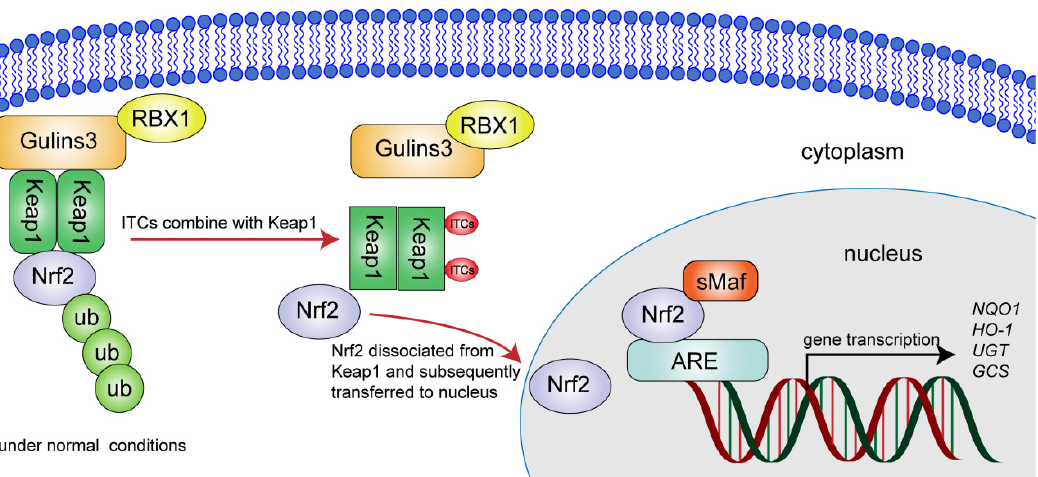
Figure 2. The regulatory effect of isothiocyanates on Keap1-Nrf2-ARE signaling pathway. Under normal conditions, Nrf2 is anchored into the cytoplasm by binding to Keap1, which facilitates the proteasomal degradation by ubiquitination. Under the action of the chemoprotective inducers ITCs, nascent Nrf2 translocates to the nucleus due to binding of ITCs to the sulfhydryl group of Keap1, and then binds to antioxidant response element (ARE) sequences in the nucleus, promoting the expression of genes and enzymes that regulate redox homeostasis. Red, purple, yellow, and light green ellipses represent ITCs, Nrf2, PBX1, and ub, while orange, dark green, blue, and red boxes represent Gulins3, Keap1, ARE, and sMaf, respectively. ub, ubiquitination; sMaf, small Maf proteins.